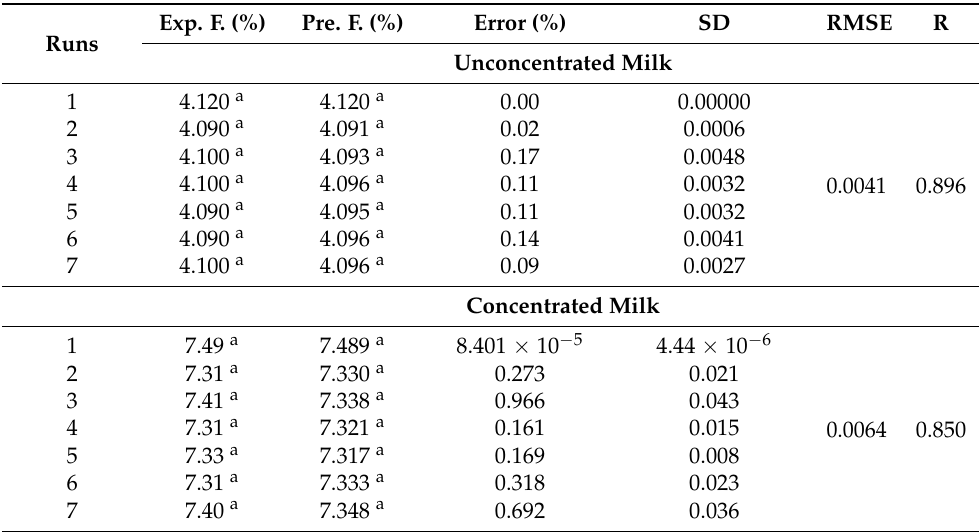
Table 2. Statistical parameters of experimental and predicted unconcentrated and concentrated milk fat values affected by color